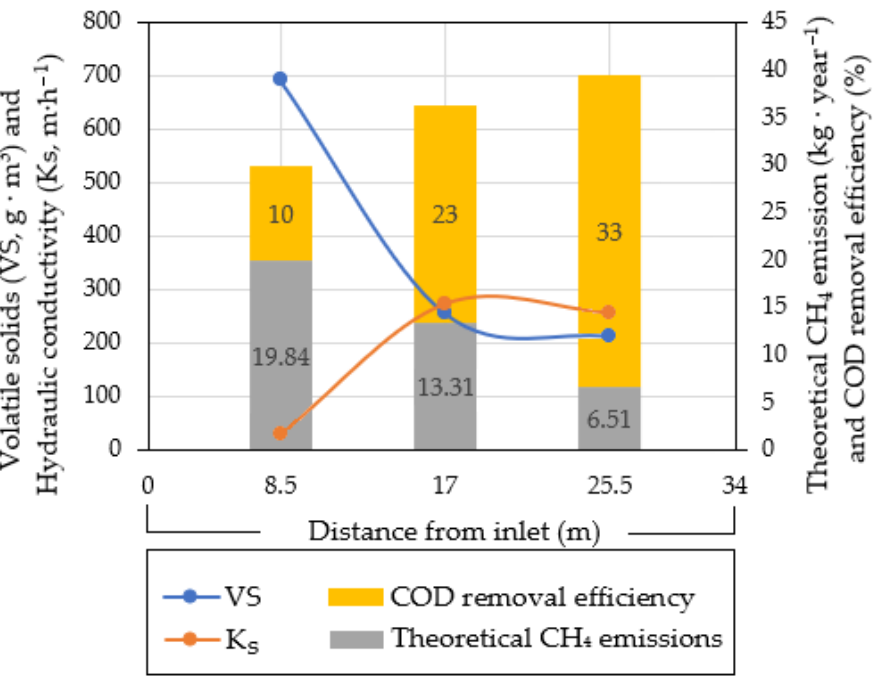
Figure 4. Data comparison with the distance from the inlet of volatile solid average values (VS, g·m −3 ); Ks average values (m·h − 1 ) reported [16] (m·h − 1 ), COD removal efficiency (%), and theoretical CH 4 emission (kg·year −1